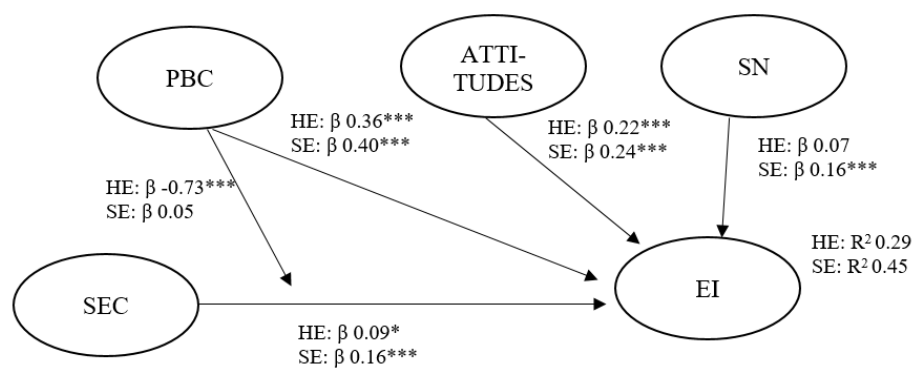
Figure 1. Final model (HE = higher education; SE = secondary education, SEC = sustainable entrepreneurship competence, PBC = perceived behavioral control, SN = subjective norm, EI = entrepreneurial intentions. * p < 0.05, *** p < 0.001